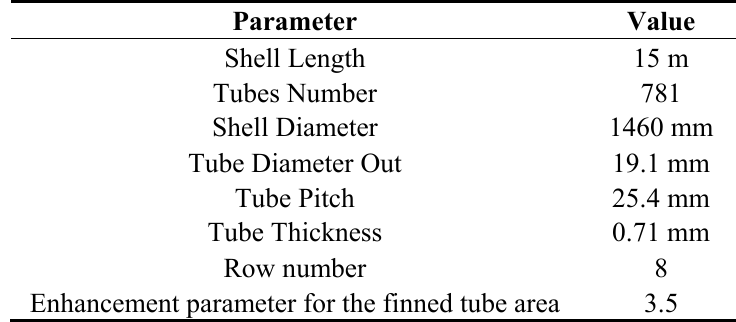
Table 6. Geometrical features of the condenser.